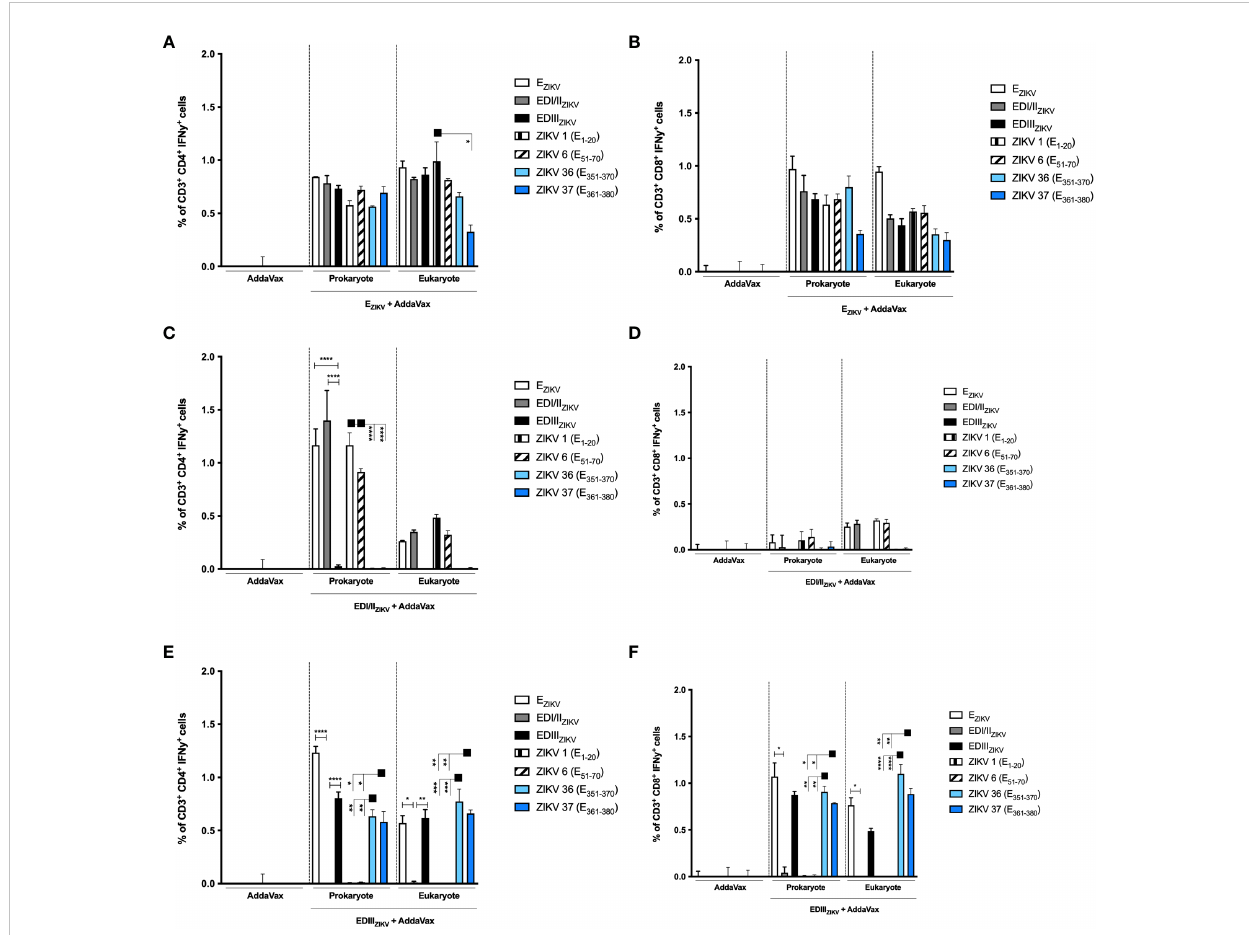
FIGURE 6 Immunization with recombinant ZIKV proteins induces CD4 + IFN g + and CD8 + IFN g + T cell responses. Percentage of (A, C, E) CD4 + IFN g + and (B, D, F) CD8 + IFN g + T cells in mice immunized with antigens produced in bacterial or insect cells: (A, B) E ZIKV , (C, D) EDI/II ZIKV and (E, F) EDIII ZIKV . Fifteen days after the second dose, spleen cells of each mouse were removed and cultured for 12 hours in the presence of equimolar amounts of recombinant proteins or ZIKV-speci fi c peptides, anti-CD28 mAb and brefeldin A. The cells were stained with anti-CD3 and -CD4 antibodies and, subsequently, permeabilized and labeled for intracellular cytokines. The percentage of cells that produce cytokines was calculated by subtracting the values obtained with unstimulated cells. Statistical signi fi cance was measured by Two-way ANOVA followed by Tukey ’ s post hoc test, *p < 0.05, **p < 0.01, ***p < 0.001, ****p < 0.0001. Data represent mean ± SD and are representative of 3 independent